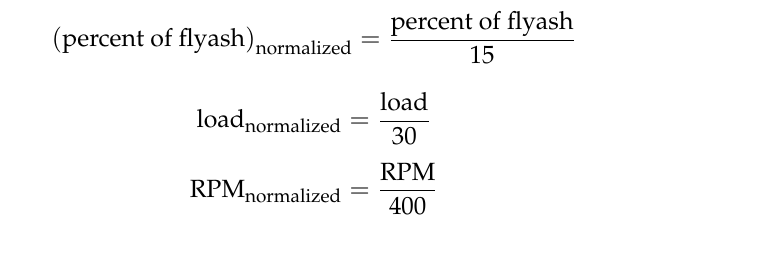
Table 5. Actual experimental data. Percentage of Flyash (F)